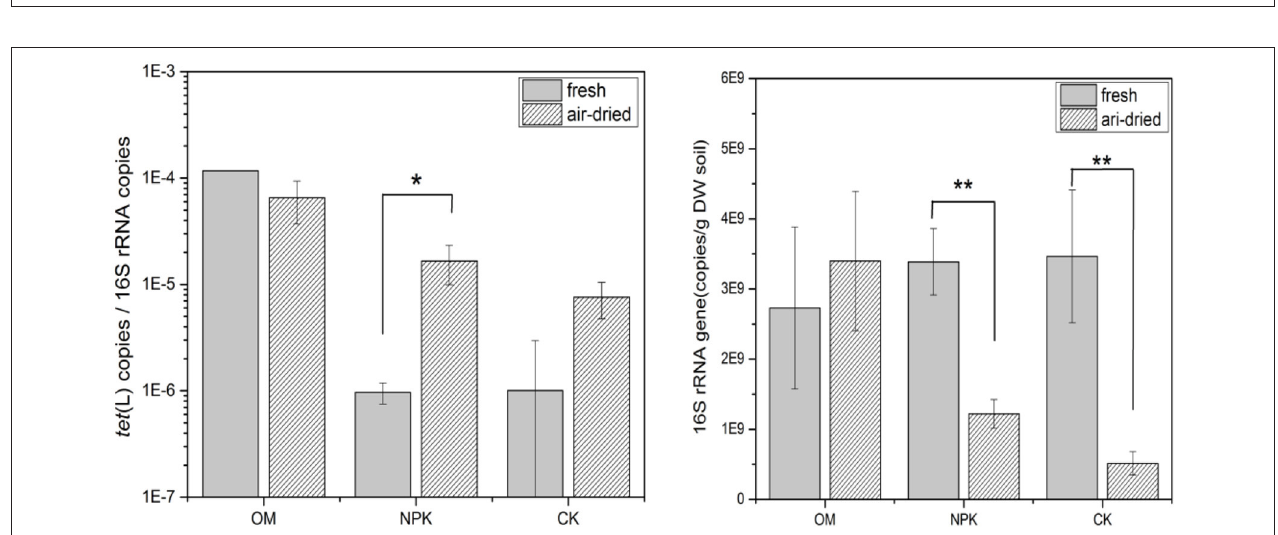
FIGURE 1 | The relative abundance of ARGs in fresh soil fertilized with OM or NPK and CK.